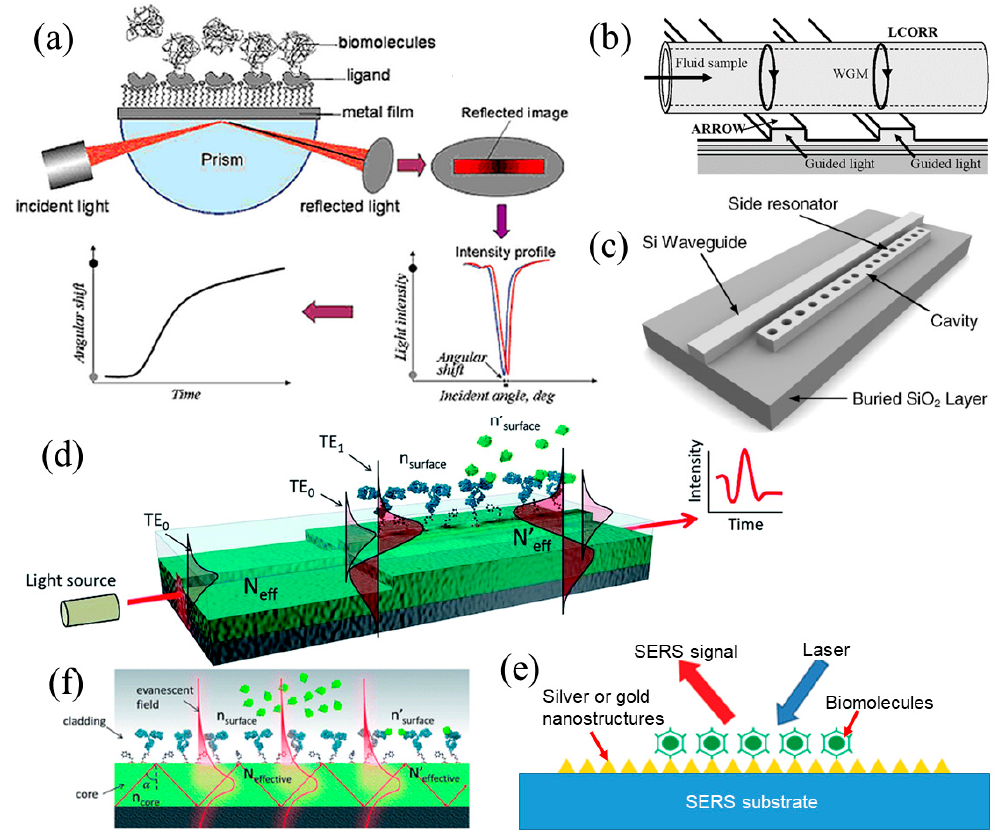
Figure 2. ( a ) A light is beamed upon a metal film through a prism and the reflected beam image shows a dark line due to surface plasmon resonance (SPR). The intensity profile of the reflected beam exhibits a dip or minimal intensity at the resonance angle. A SPR experiment measures the position shift of the dip (the angle shift) upon molecular adsorption, and this shift represents the adsorption kinetics when plotted as a function of time; ( b ) liquid core ring resonator (LCORR) sensor; ( c ) photonic crystal-based biosensor; ( d ) bimodal waveguide interferometric (BiMWI) biosensor; ( e ) evanescent field biosensor and (f) surface enhanced Raman spectroscopy (SERS) sensor. Reproduced from references [61,62,66,71] with permission from AIP Publishing, Optical Society of America and Royal Society of